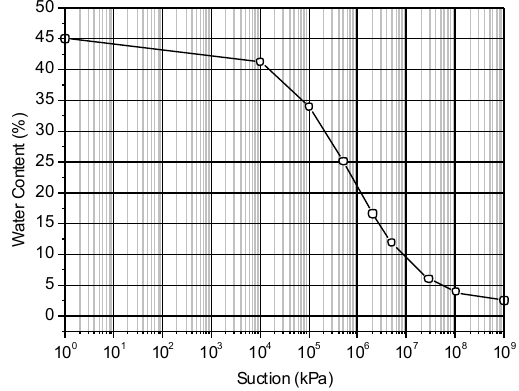
Figure 5d. Thermal Conductivity (Case Study)